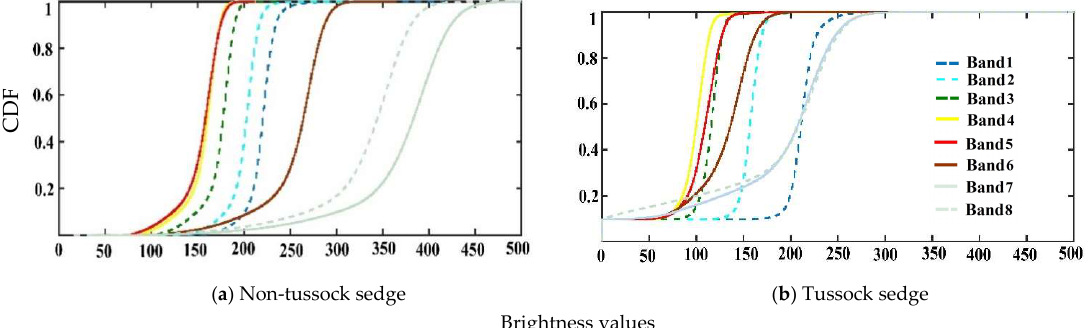
Figure 3. Cumulative distribution function for the multispectral band datasets.